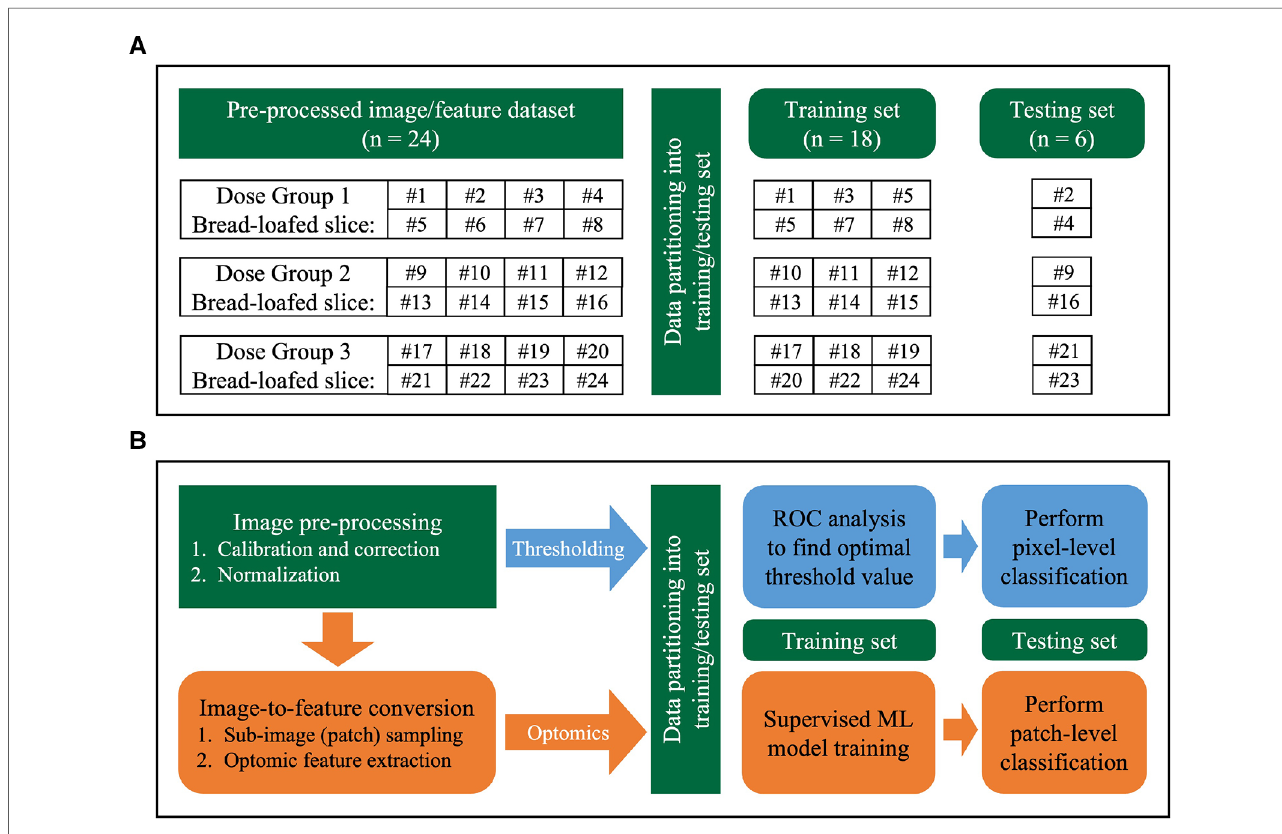
FIGURE 4 Image analysis work fl ow. ( A ) Data partitioning strategy. Bread-loafed slices were partitioned 75%/25% into aggregated training and testing sets. The same specimen-level partitioning strategy was used to assess the performance of both methods. ( B ) Work fl ow comparison of thresholding and optomics methods. Green modules indicate steps shared by the two methods. Blue and orange modules represent the steps unique to the thresholding and optomics approaches,